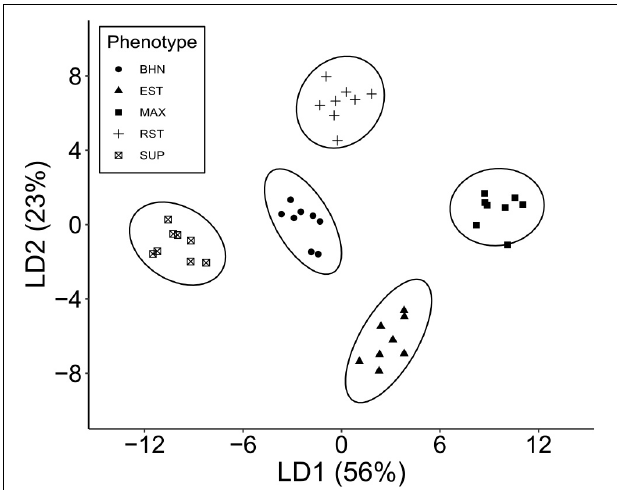
FIGURE 7 | Linear discriminant analysis based on ten nutrients (B, Ca, Cu, Fe, K, Mg, Mn, Na, P, Zn) at 3 times points (26, 62, 126 DAP) and C and N at 126 DAP for four grafted phenotypes (Estamino, Maxifort, RST-04-106-T, and Supernatural) and one cultivar (BHN-589) ( n = 8). Total variance explained by the first two discriminant functions are presented in